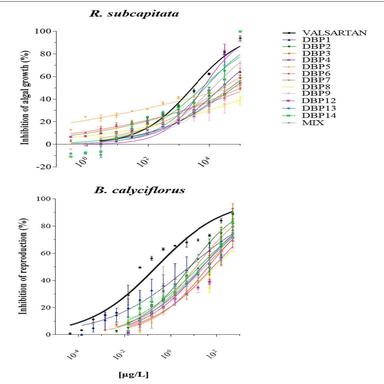
Concentration/effect curves of chronic toxicity of valsartan, DBPs and MIX in R. subcapitata and B. calyciflorus. Results are reported as EC50 . Bars show Standard Deviation (SD, n = 3).